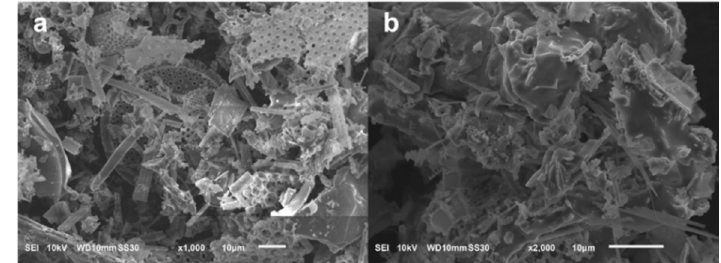
Figure 1. SEM images of ( a ) raw diatomite (DE) and ( b ) DE immediately before the hydrothermal treatment.